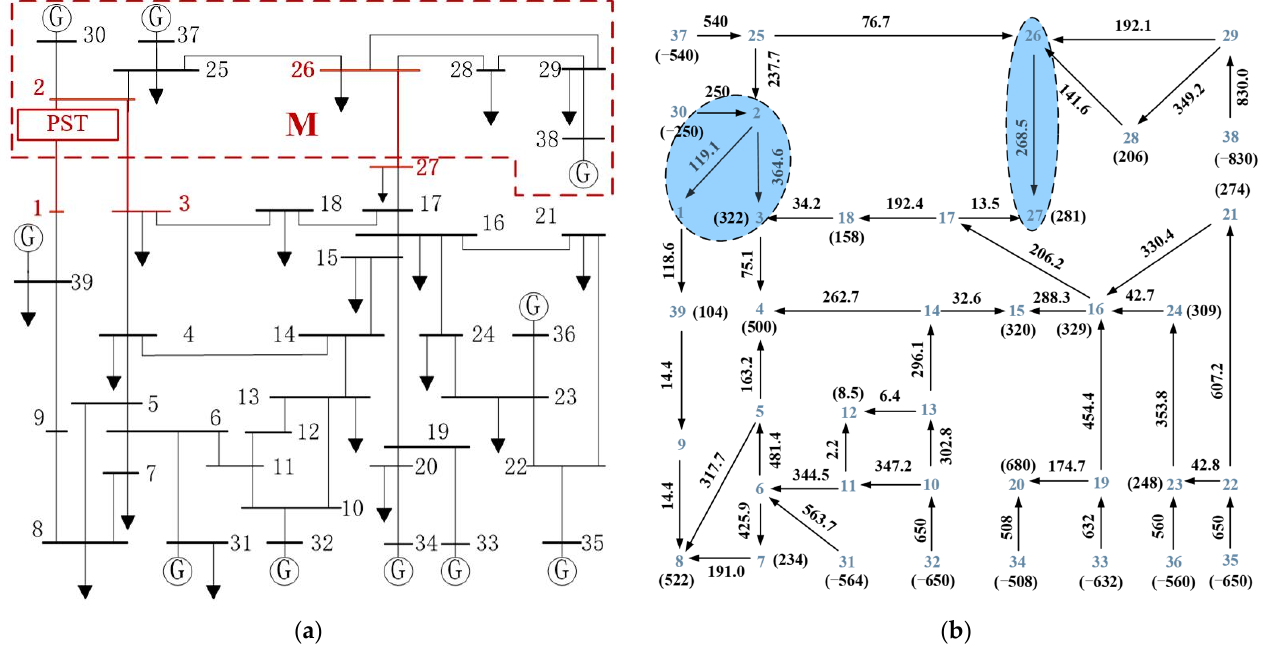
Figure 8. Initial power flow of IEEE39 nodes. ( a ) PST location diagram, ( b ) Initial power flow distribution diagram.